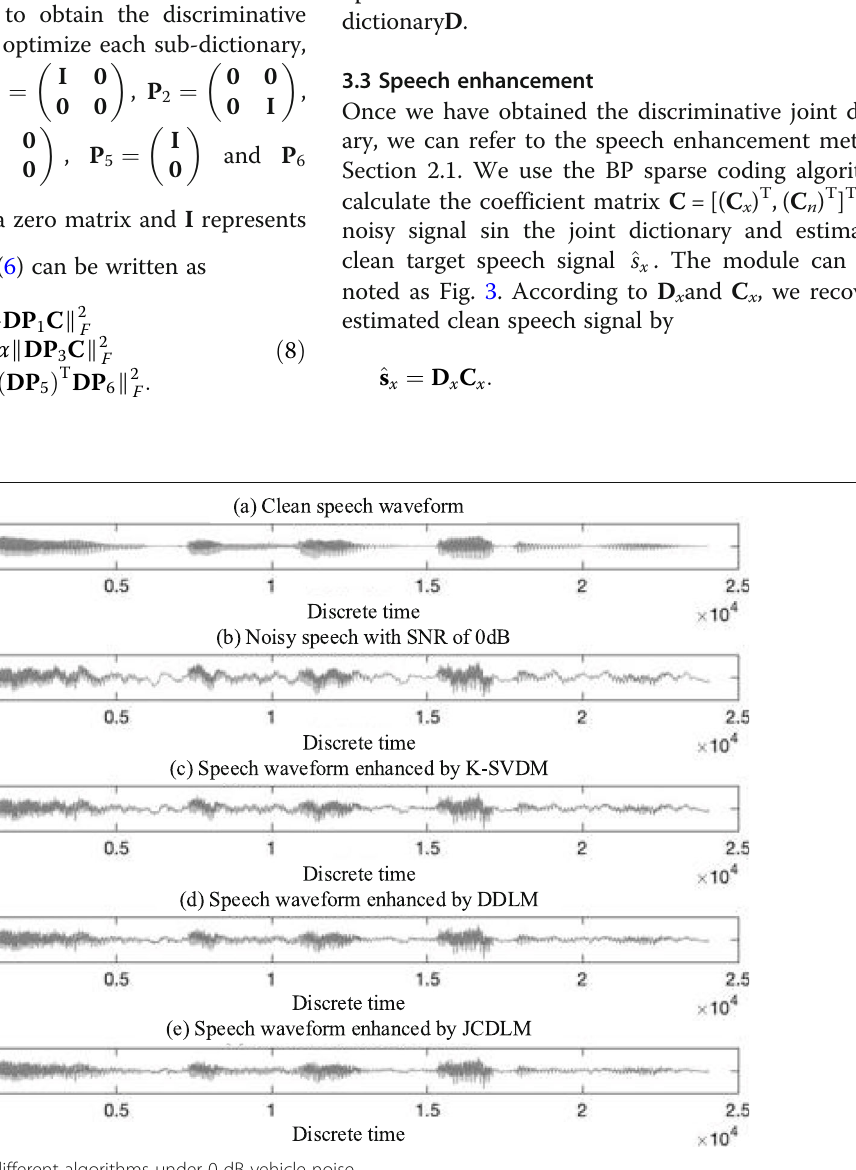
Fig. 7 Enhanced waveforms of different algorithms under 0-dB vehicle